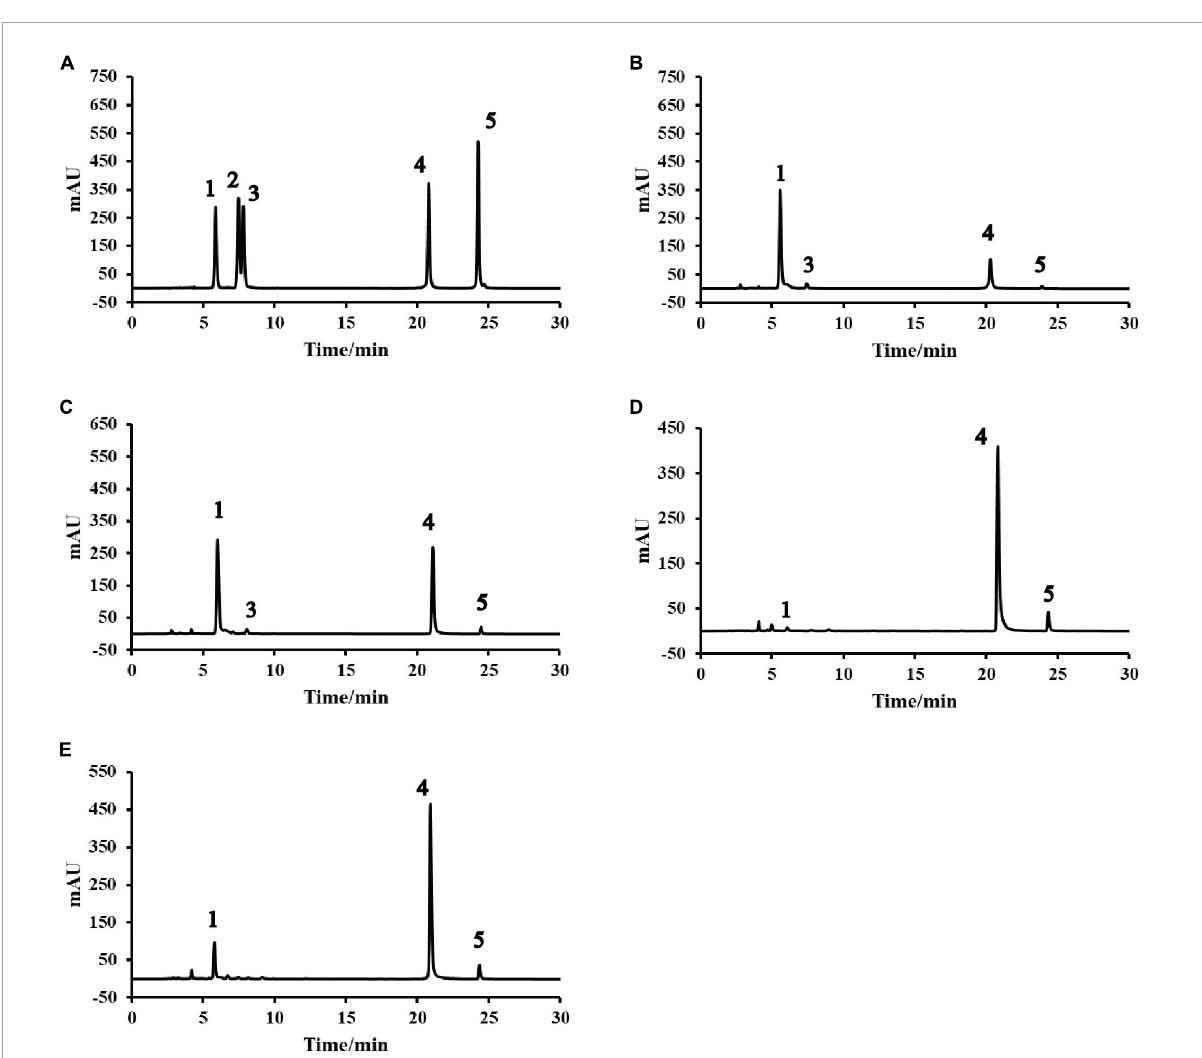
FIGURE1 High performance liquid chromatography (HPLC) profiles of native and pregelatinized Tartary buckwheat flour: (A) Standards. (B) Native. (C) T160M30. (D) T100M30. (E) T70M30. (1) Rutin. (2) Isoquercitrin. (3) Kaempferol-3- O -rutinoside. (4) Quercetin. (5) Kaempferol. TxMy, x is the extrusion temperature at the fourth zone ( ◦ C) and y is the feed moisture content